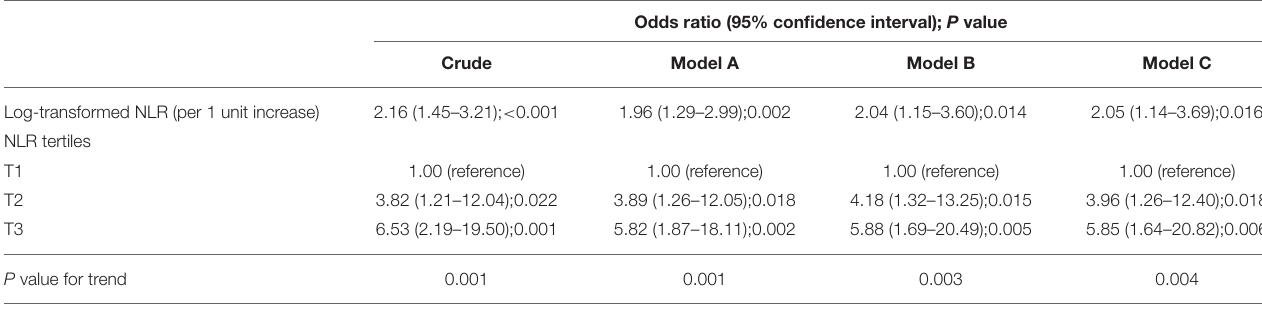
TABLE 3 | The association between NLR and catheter removal in GEE models.